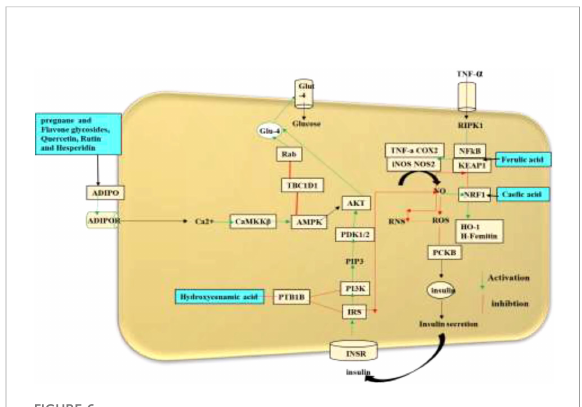
FIGURE 6 Schematic representation of the antidiabetic mechanisms of the natural compounds in Caralluma tuberculata